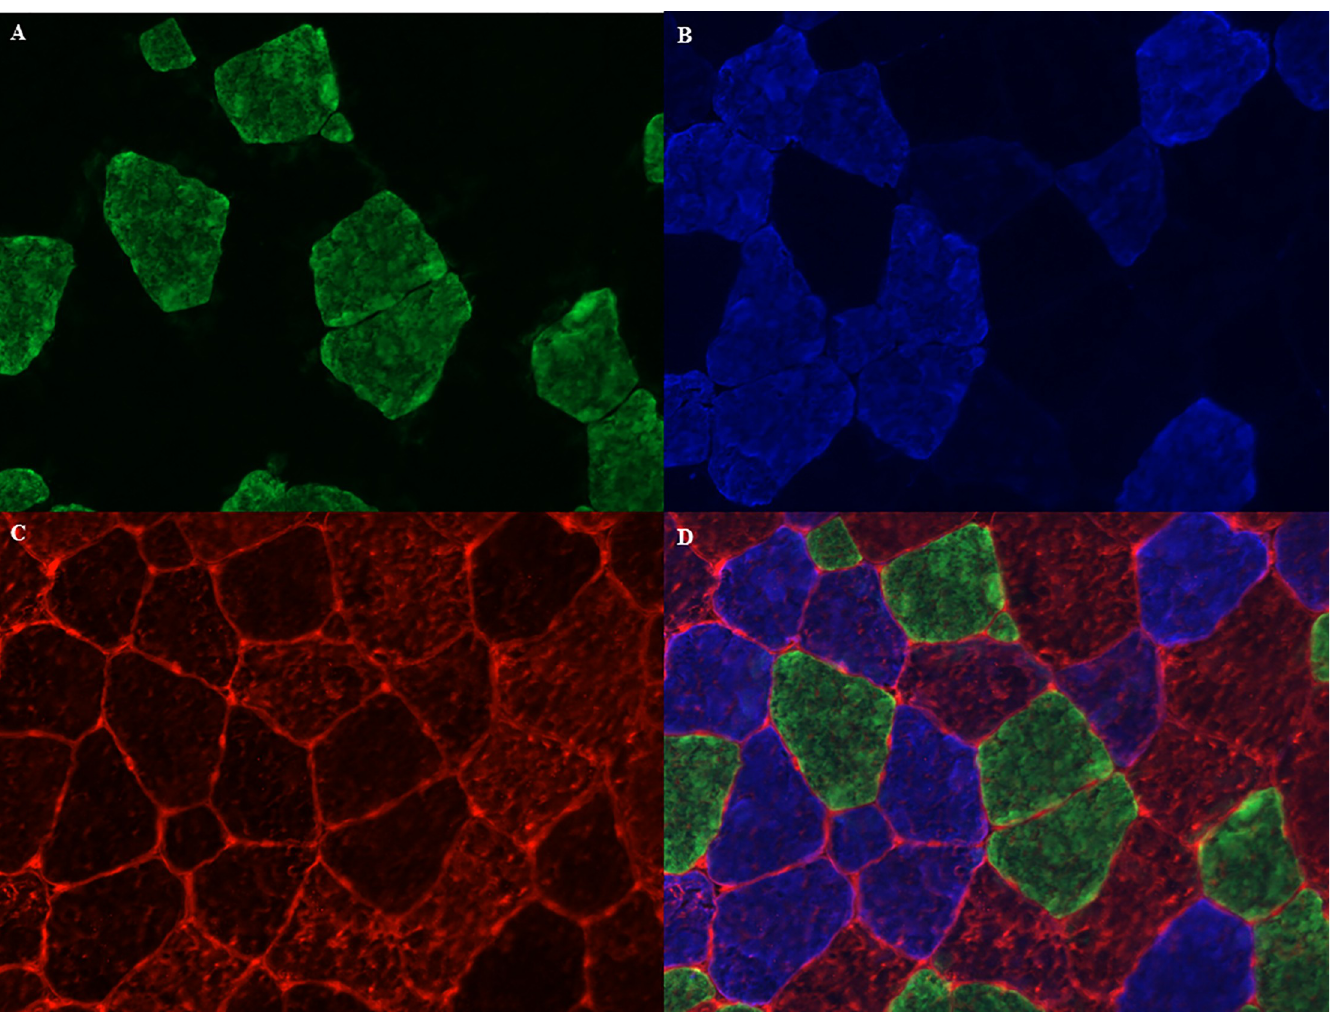
Fig 4. Muscle fiber typing with myosin heavy chain staining method. (A) type I fibers in green; (B) type IIA fibers in blue; (C) type IIX fibers and sarcolemma in red; (D) merged image.